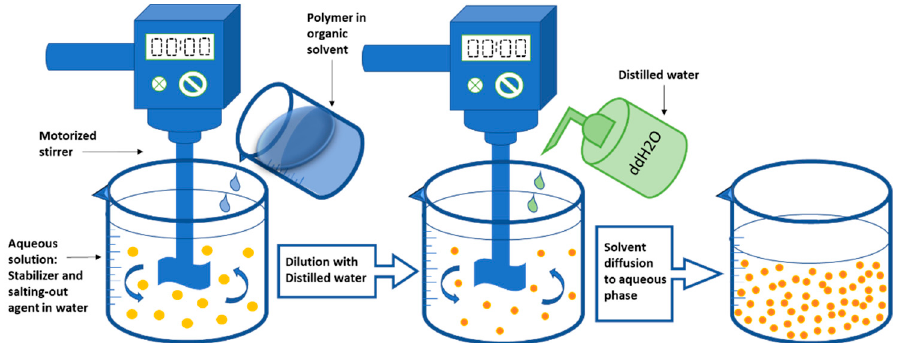
Figure 5. Diagrammatic interpretation of the salting-out technique.